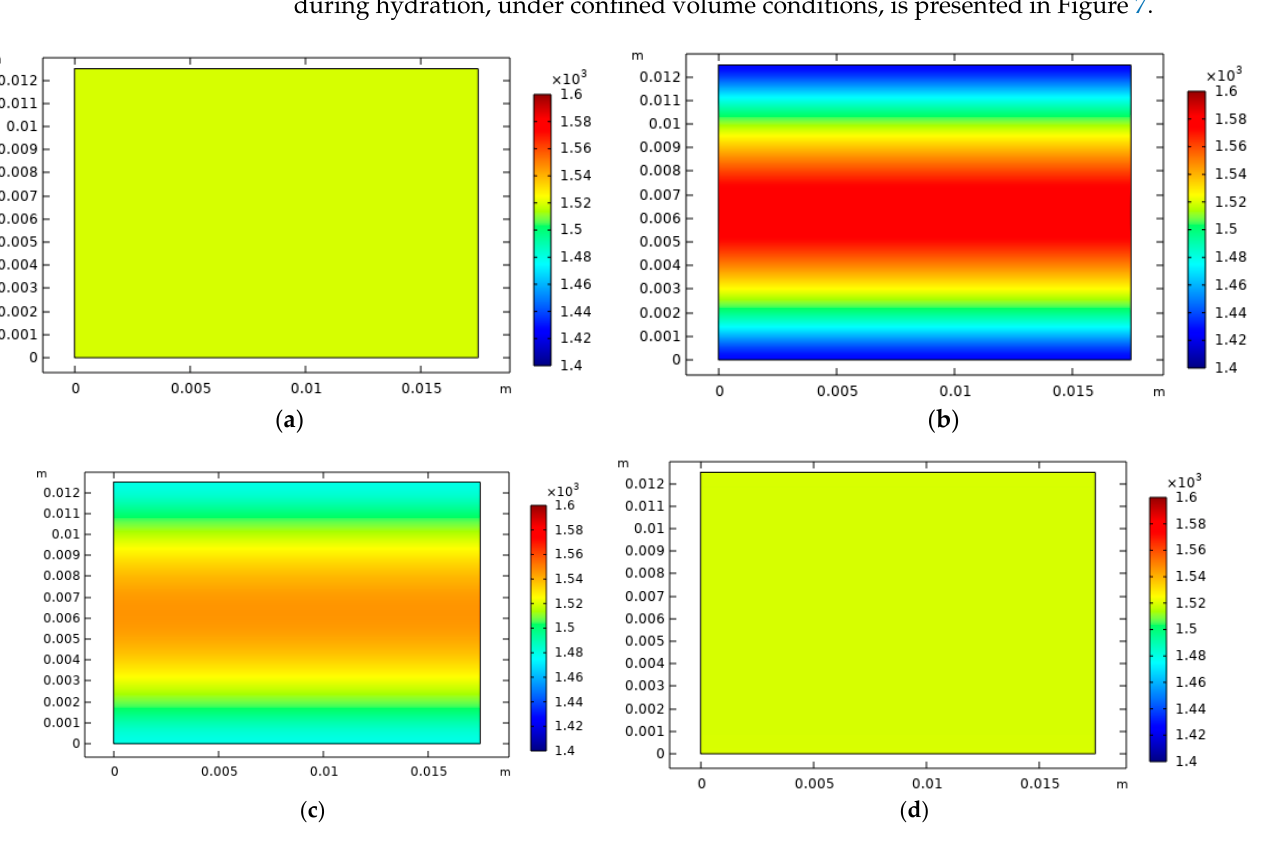
Figure 6. The degree of saturation of the sample at different times (( a ) t = 0, ( b ) t = 200 min, ( c ) t = 500 min, ( d ) t = 1200 min) (Path AB’C’, hydration stage AB’).